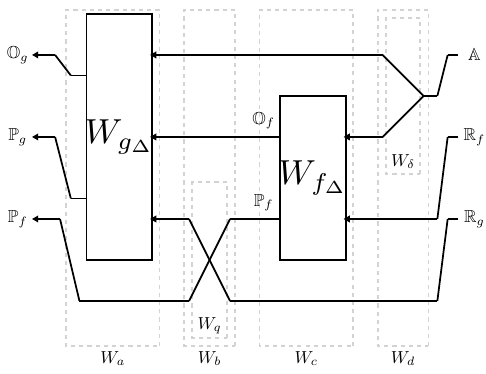
Figure 19: Map between Fourier transforms of probability distributions implied by the considered example composition pattern.